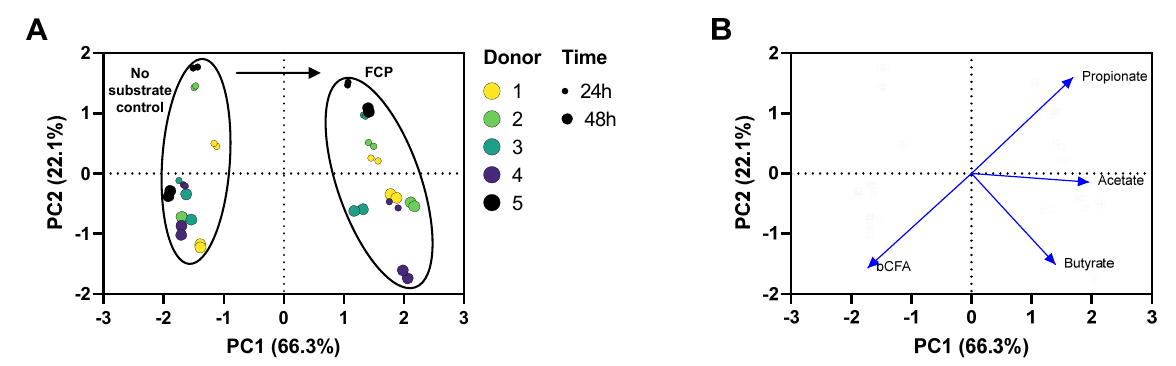
Figure 2. ( A ) PCA based on microbial metabolic activity on different time points (24 h and 48 h) during the incubation of human faecal microbiota of five different human donors in presence of FCP versus a no substrate control. All conditions were tested in technical duplicate. ( B ) Loadings of the parameters on which the PCA was based: acetate, propionate, butyrate, and bCFA. PCA, principal component analyis.